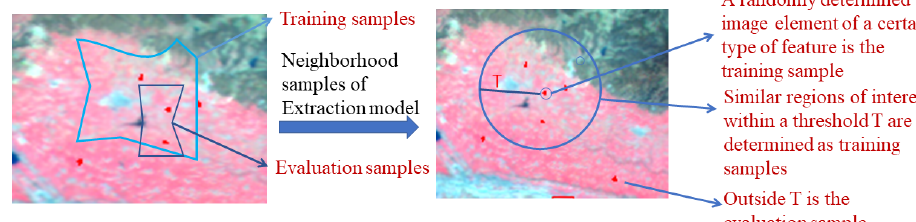
Figure 3. Improvement of sample extraction